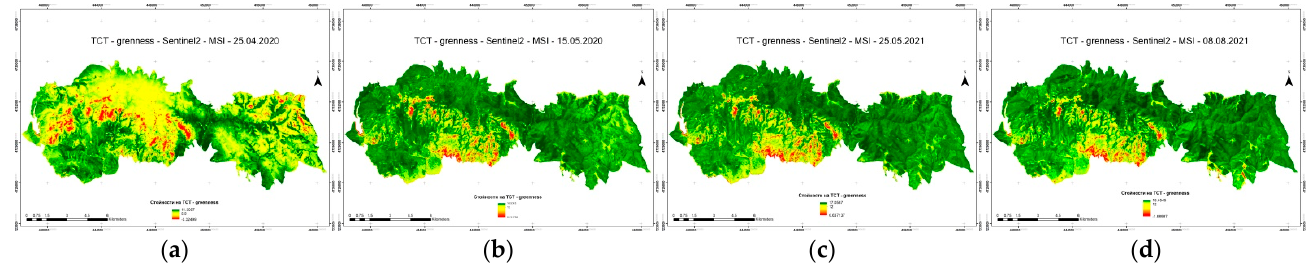
Figure 2. Maps of the TCT– greenness component values from: ( a ) 25 April 2020; ( b ) 15 May 2020; ( c ) 25 May 2021; ( d ) 08 August 2021.